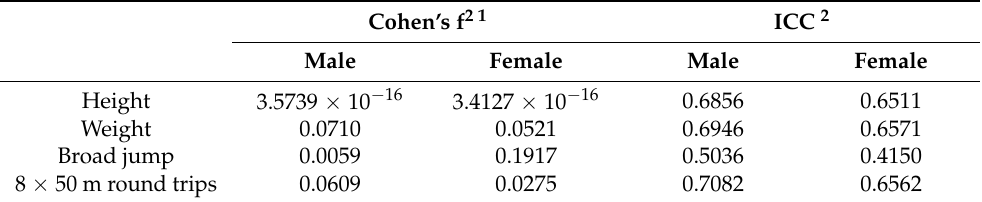
Table A3. Random effects and fixed effects effect sizes of height, weight, broad jump, 8 × 50 m round